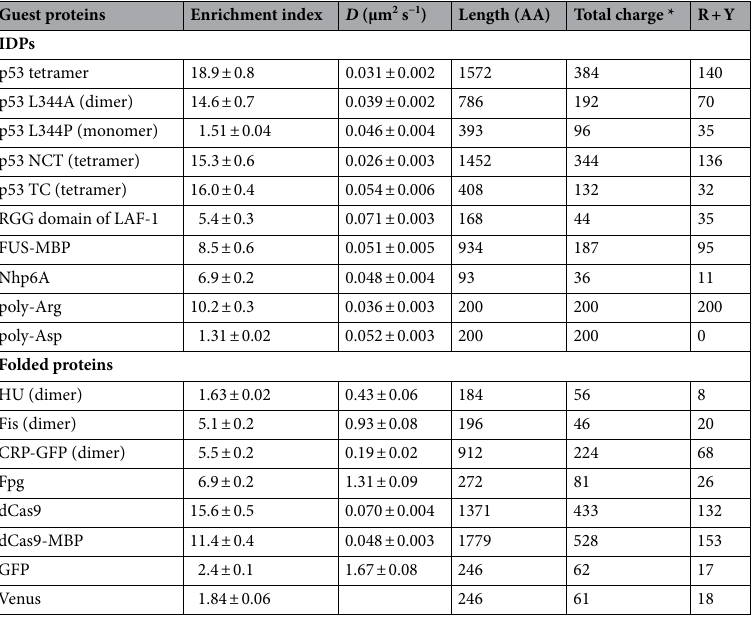
Figure 3. Molecular interaction between host and guests affects recruitment into liquid p53 tetramer droplets. ( A ) Protein length dependence of enrichment index (EI) of guest proteins. ( B ) Total charge dependence of EI of guest proteins. ( C ) EI of guest proteins against a function of R plus Y number. ( D ) EI of DNAs against a function of dissociation constant of DNAs to p53 tetramer. In all panels, errors denote standard errors. In panels A–C, best-fitted lines for the guest folded proteins (red) and intrinsically disordered proteins (IDPs) (blue) are displayed as a guide for eye. Guest proteins Enrichment index D (μm 2 s −1